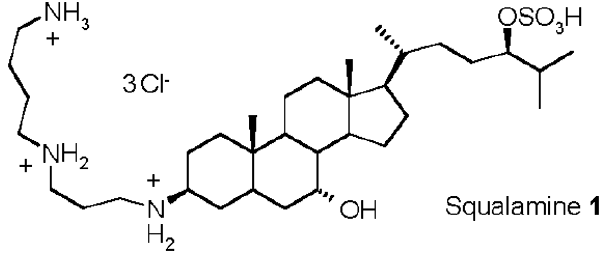
Figure 2. Structure of squalamine 1.